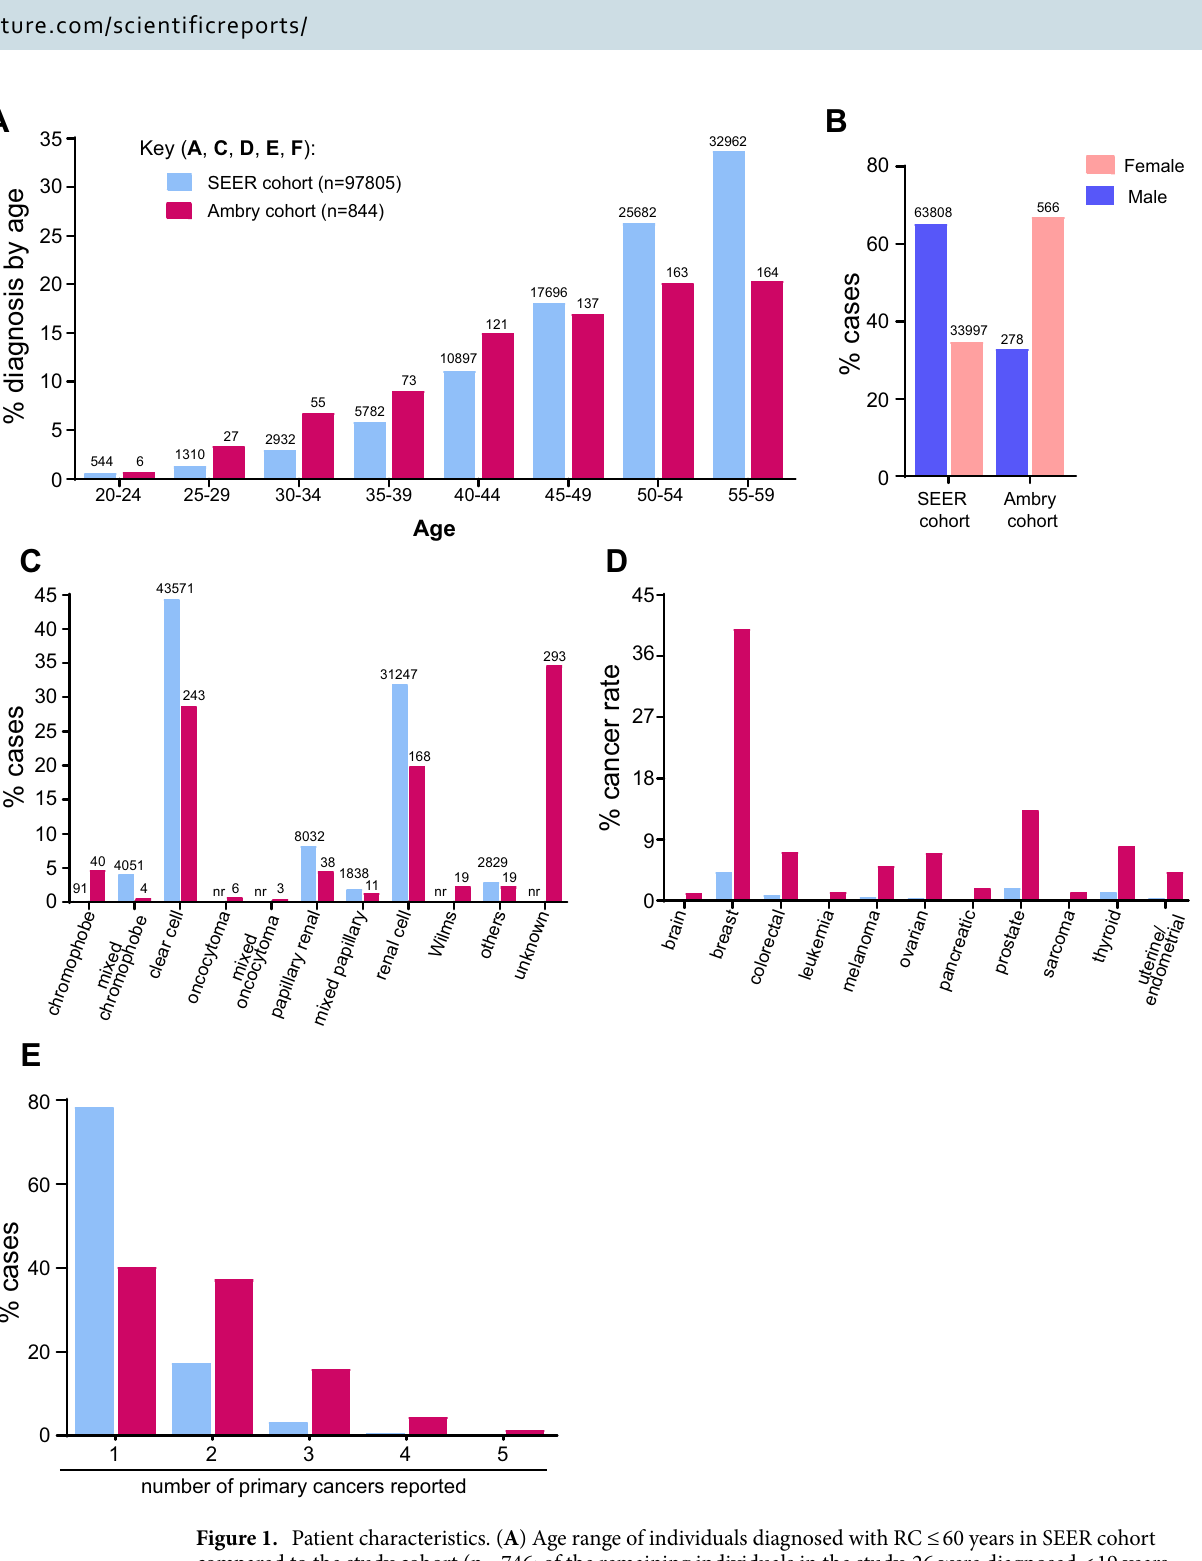
Figure 1. Patient characteristics. ( A ) Age range of individuals diagnosed with RC ≤ 60 years in SEER cohort compared to the study cohort (n = 746; of the remaining individuals in the study, 26 were diagnosed < 19 years, 33 were diagnosed at 60 years, and 39 were excluded from the calculations as their age was reported as a wide range of years). ( B ) Percentage of males and females diagnosed with RC ≤ 60 years in SEER compared to the study cohort (n = 844). ( C ) The percentages of reported RC histology up to age 60 years in the SEER data (n = 97,805) compared to the study cohort (n = 844); not all histological subtypes reported in SEER were reported in the study cohort . ( D ) The percentage of cancer incidence (at ≤ 60 years) in the general SEER population versus the study cohort. The SEER data reflect individuals reporting the indicated cancer type, not individuals with RC in addition to the indicated cancer type. ( E ) Percentage of different primary cancers reported (≤ 60 years) in SEER (n = 97,795) versus the study cohort (n = 844). Less than 0.4% not reported for figure